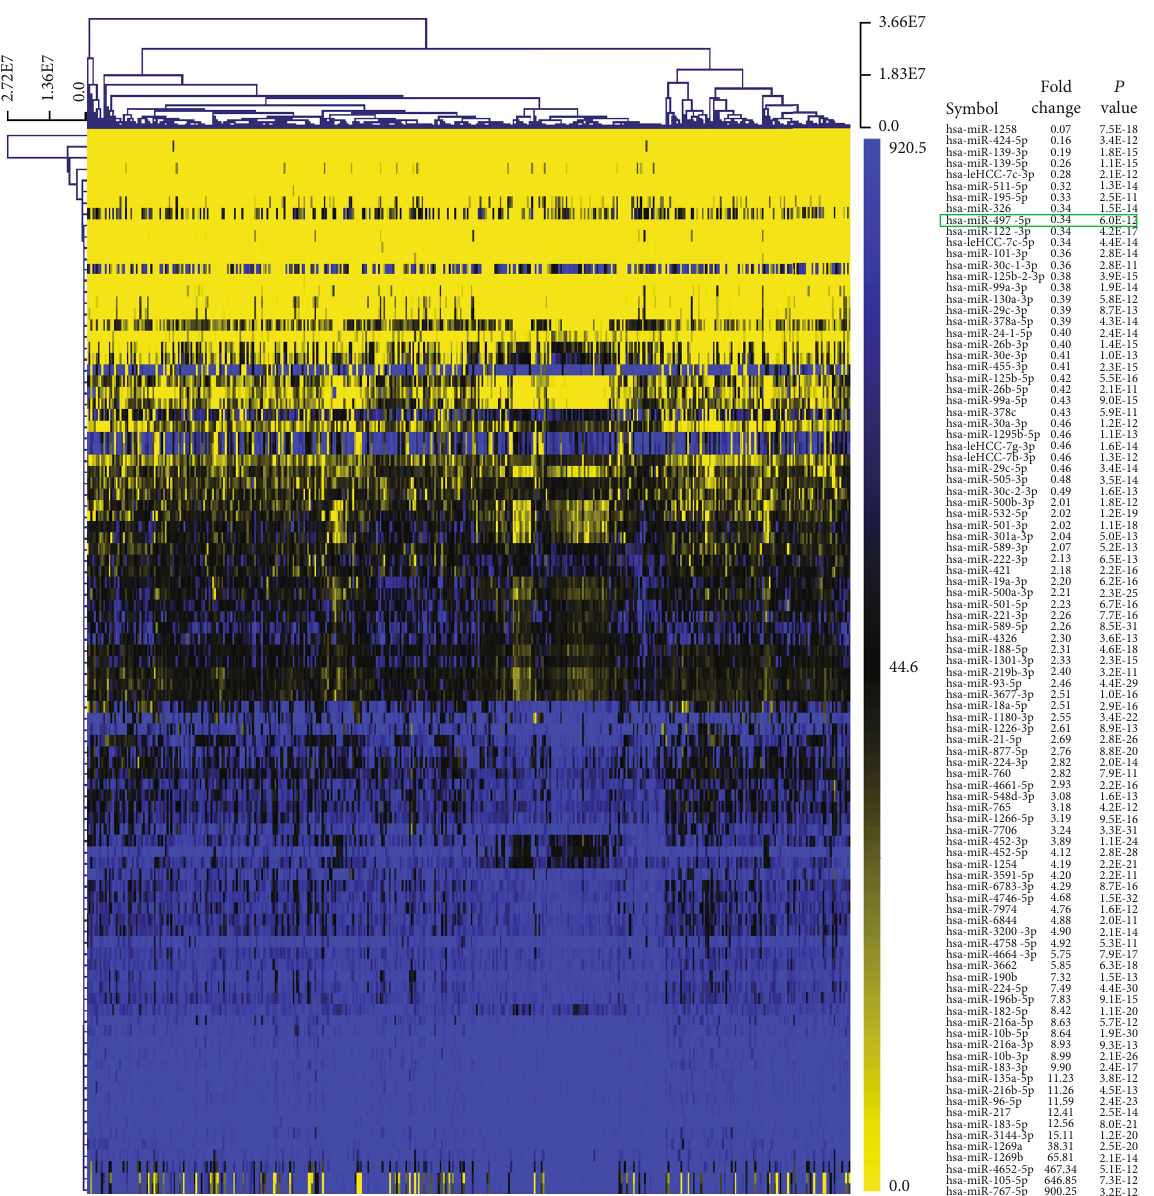
Figure 1: Cluster analysis of miRNA expression in HCC. Cluster analysis of miRNA expression in HCC was performed by MeV software (version